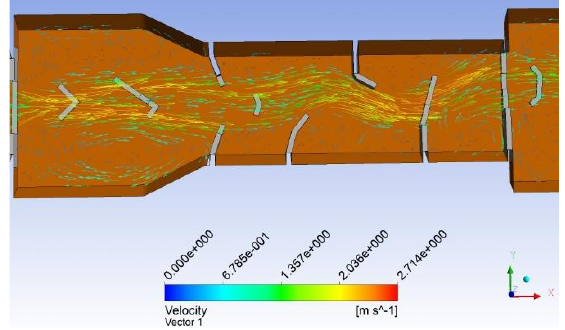
Figure 11. a, b, c Assymetric section No. 4 without and with water, map of obstacle distribution (each colour represents a different size obstacle); mathematical modelling of flow.